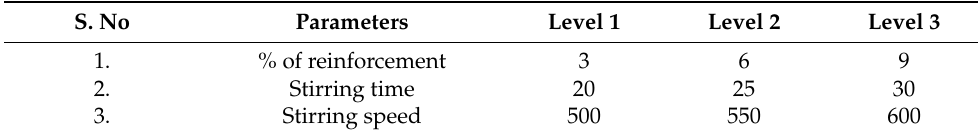
Table 3. Process parameters and their levels of stir casting process.